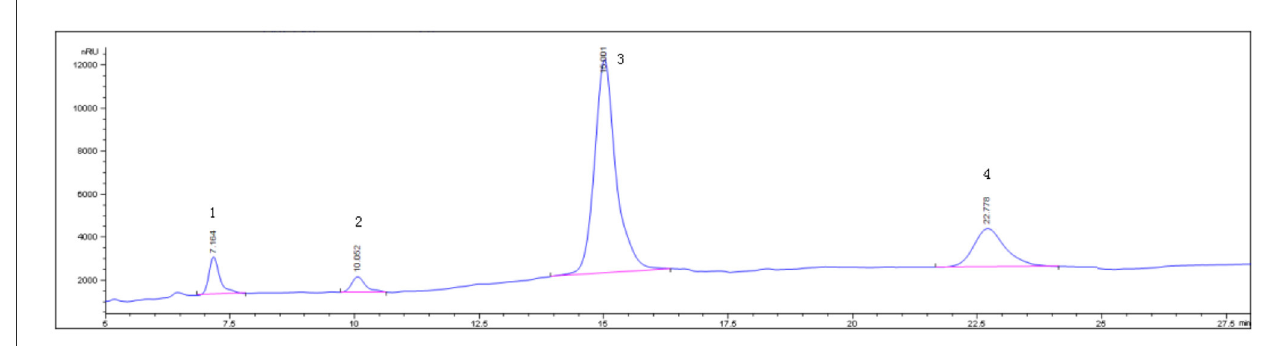
FIGURE1 RGO HPLC chromatogram (1 sucrose, 2 raffinose, 3 stachyose, 4